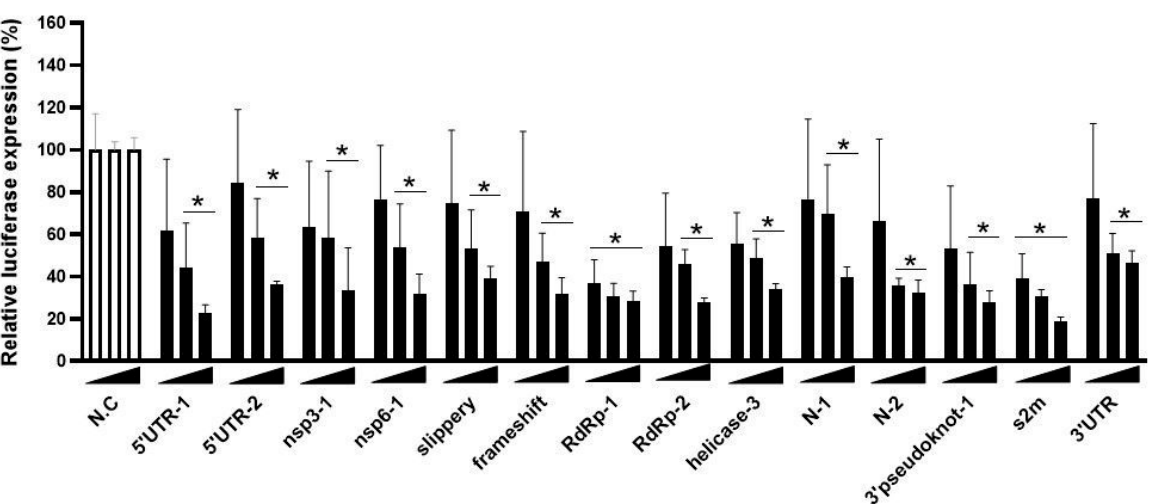
Figure 4. Titration of SARS-CoV-2 targeting crRNAs. The efficiency of 14 crRNAs was tested in HEK293T cells by co-transfecting them with the luciferase construct encoding SARS-CoV-2 +RNA target sequences. A titration of the crRNA constructs was performed (75, 150 and 300 ng). To quantify viral gene expression, luciferase level was measured at two days after transfection. Mean values ( ± SD) of three experiments in duplicate are shown. The average luciferase levels are expressed as percentage (%) of luciferase expression, setting the negative control (NC) at 100%. Statistical significance was determined using one-way ANOVA, * p ≤ 0.05.